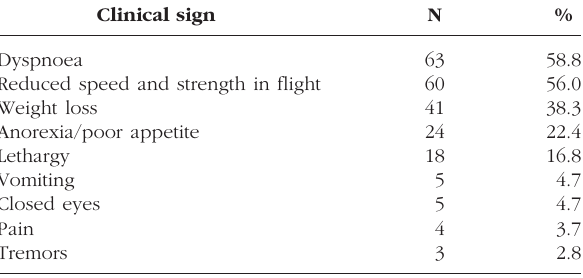
Table I. – Numbers and percentage of birds out of 107 falcons from Kuwait showing clinical signs associated with Serratospiculum infes-